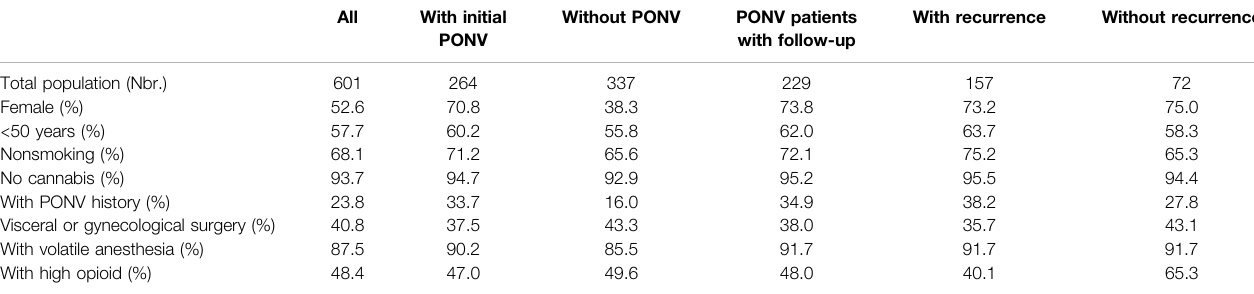
All With initial Without PONV PONV patients With recurrence Without recurrence PONV with follow-up